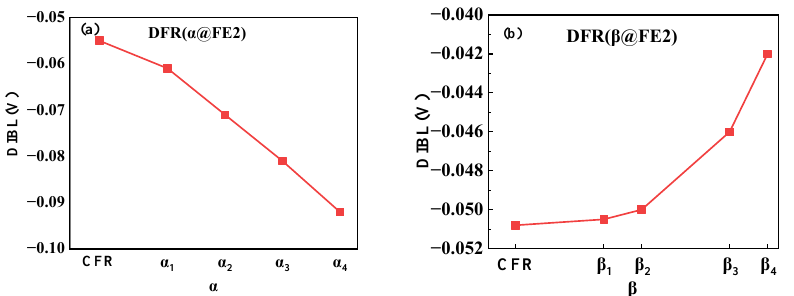
Figure 9. ( a ) Extracted DIBL versus α of FE2 and ( b ) Extracted DIBL versus β of FE2 for the DFR- NCFET and CFR-NCFET.